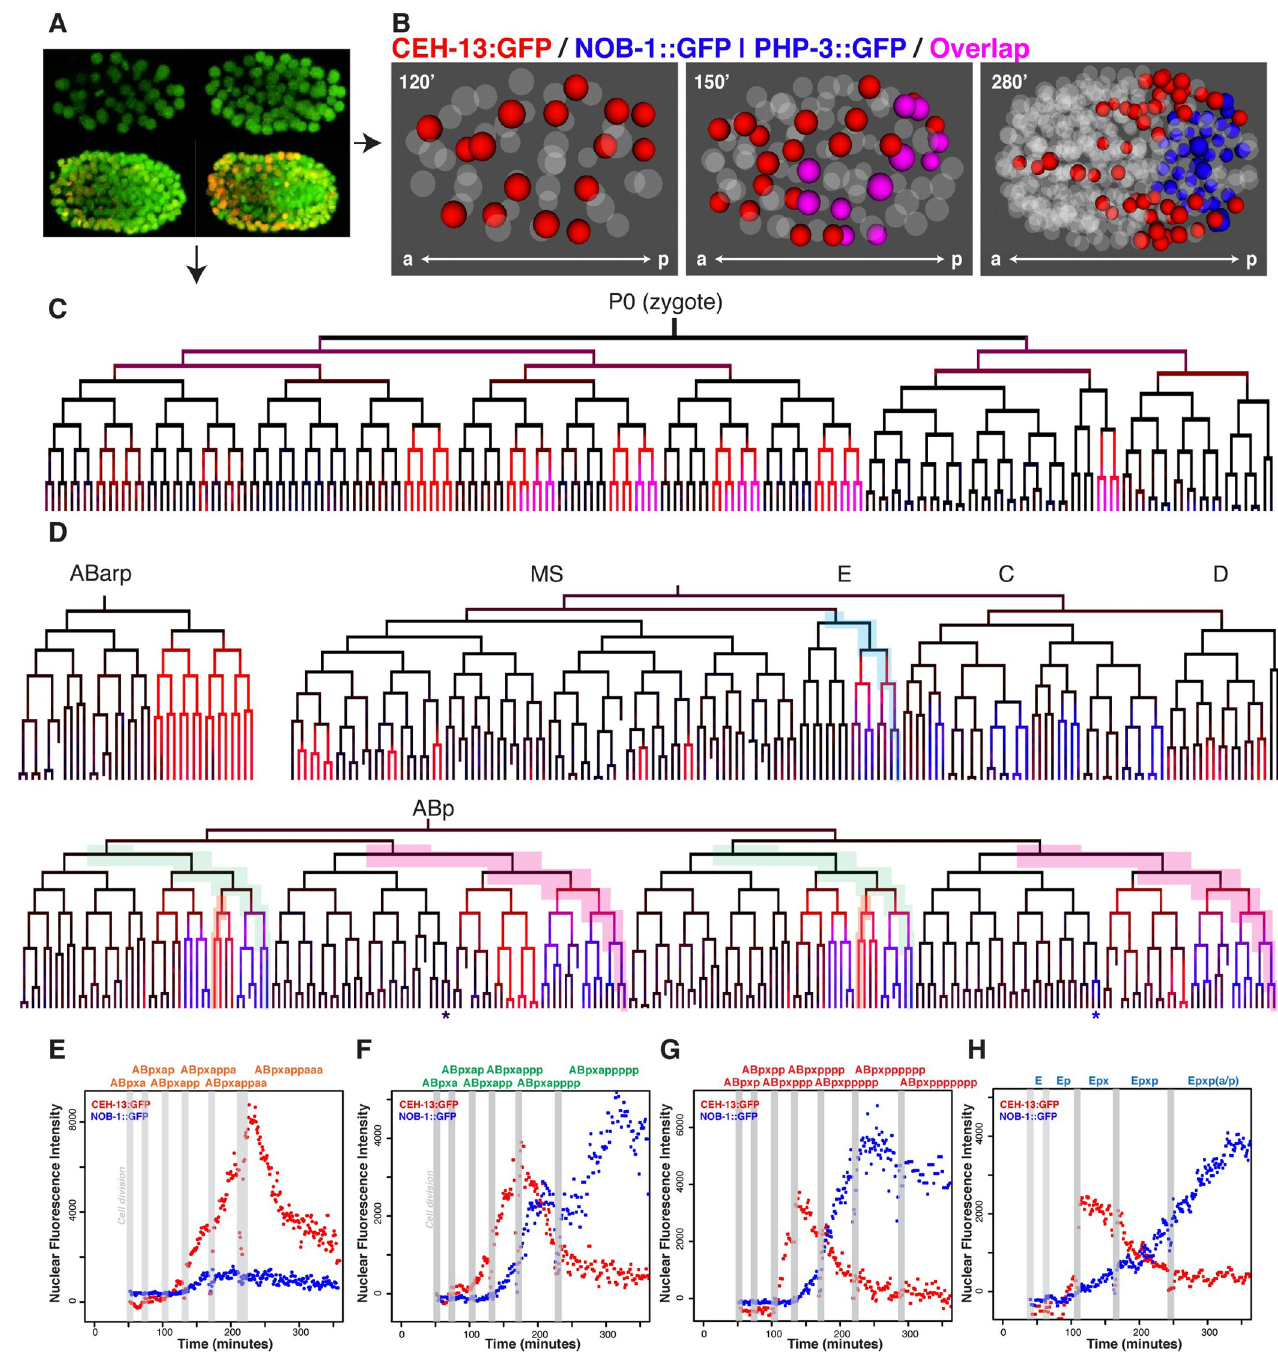
Fig 1. ceh-13 and nob-1/php-3 are expressed broadly in an overlapping pattern in the early C . elegans embryo. A) Time-lapse images of transgenic C . elegans embryos carrying two transgenes, a ubiquitous fluorescent histone to mark all nuclei (shown in green) and a reporter of interest (shown in red), which can be a cis-regulatory element driving a fluorescent histone (transcriptional) or a fluorescently tagged transcription factor protein (translational). Image analysis software identifies nuclei, and quantifies reporter intensity within the nuclei, which can be displayed as a lineage tree colored by expression as in (C). B) 3D projections of nuclei expressing endogenously tagged CEH-13::GFP (red) and endogenously tagged NOB-1::GFP and PHP-3::GFP (blue), with overlap shown in magenta, at 120 minutes (50 cell stage), 150 minutes (100 cell stage), and 280 minutes (400 cell stage) post fertilization. Endogenously tagged NOB-1:: GFP and PHP-3::GFP were expressed in indistinguishable patterns (S1 Fig), but PHP-3::GFP was slightly brighter so is shown in the following panels. C) Lineage tree through the 100-cell stage, showing early expression of endogenously tagged CEH-13::GFP and PHP-3::GFP, colored as in (B). D) Expressing lineages showing endogenously tagged CEH-13::GFP and/or PHP-3::GFP expression to 350 minutes of development, colors as in (B). Note that CEH-13::GFP